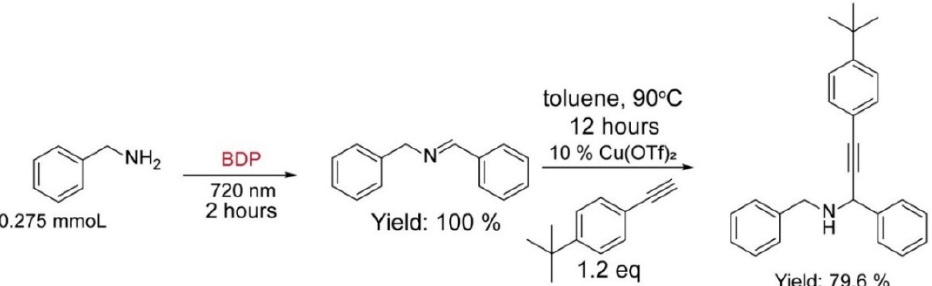
Figure 3. The tandem synthesis of the alkyne-substituted secondary amine via the combination of NIR light–driven BDP photocatalysis with copper catalysis.